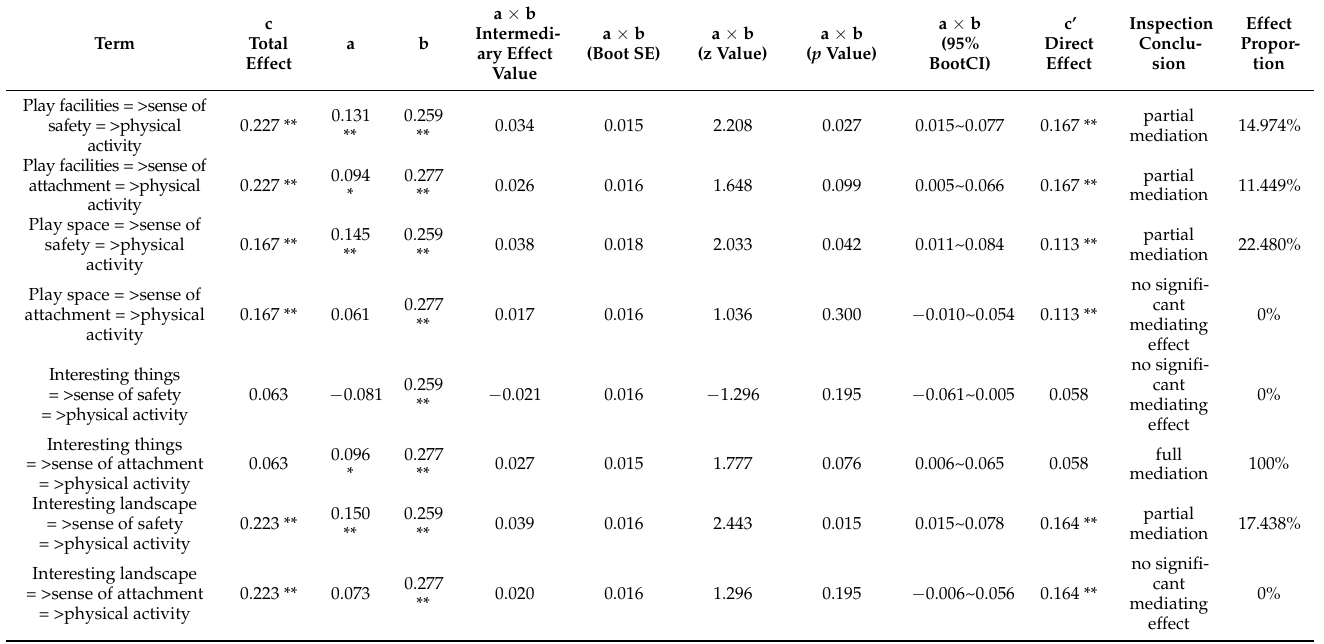
Table 8. Mediation effect test